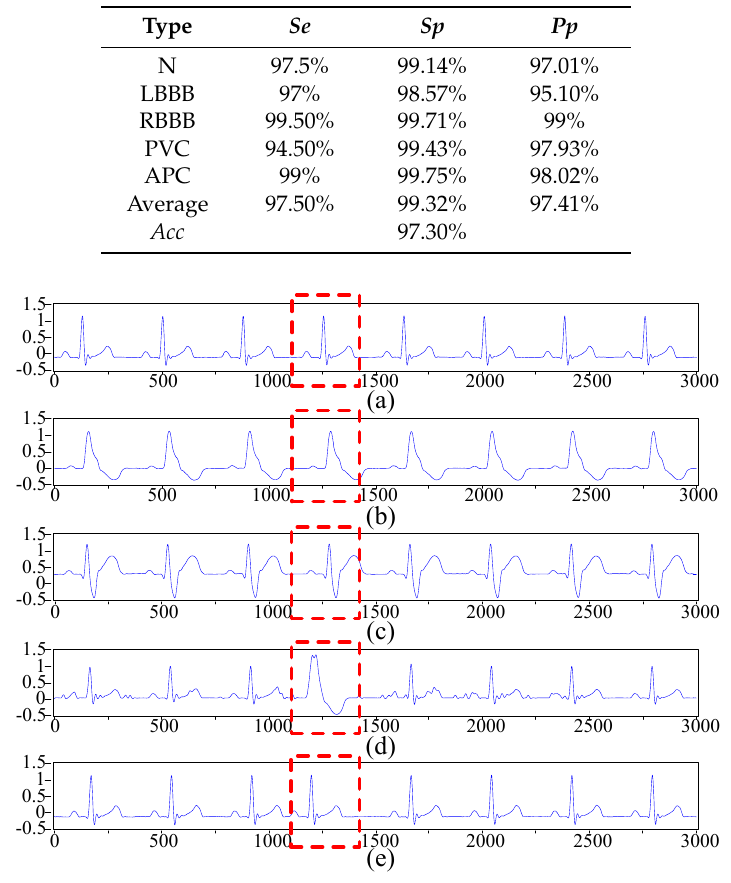
Figure 9. Five types of ECG signals acquired by the experimental platform. The ECG signals in the red dashed boxes are the five types of the acquired beats. ( a ) N; ( b ) LBBB; ( c ) RBBB; ( d ) PVC; and ( e ) APC. Table 4. The classification results based on electrocardiogram (ECG) acquisition experiment platform.